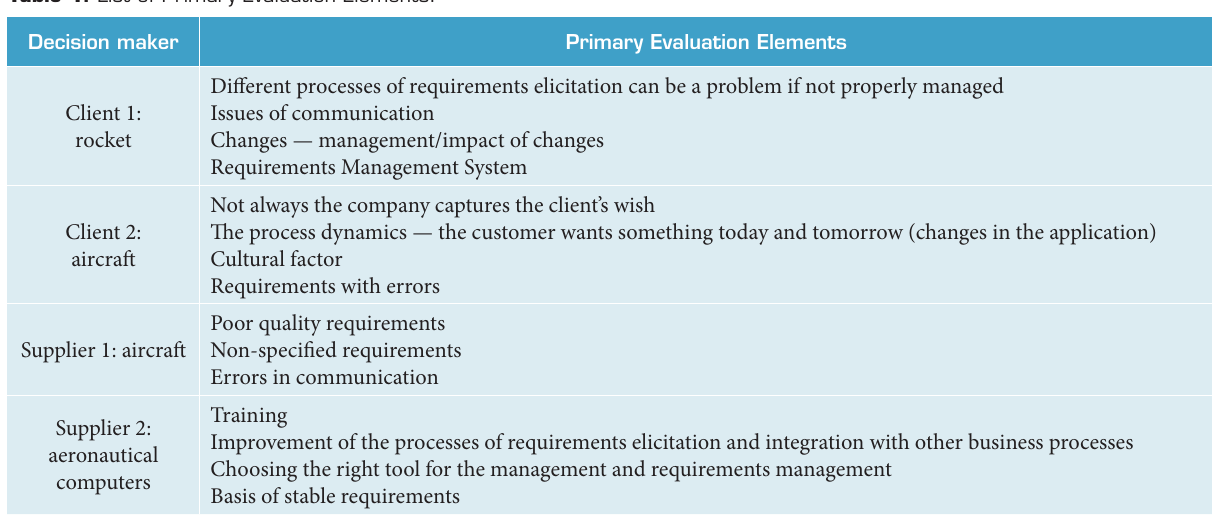
table 1. List of Primary Evaluation Elements.